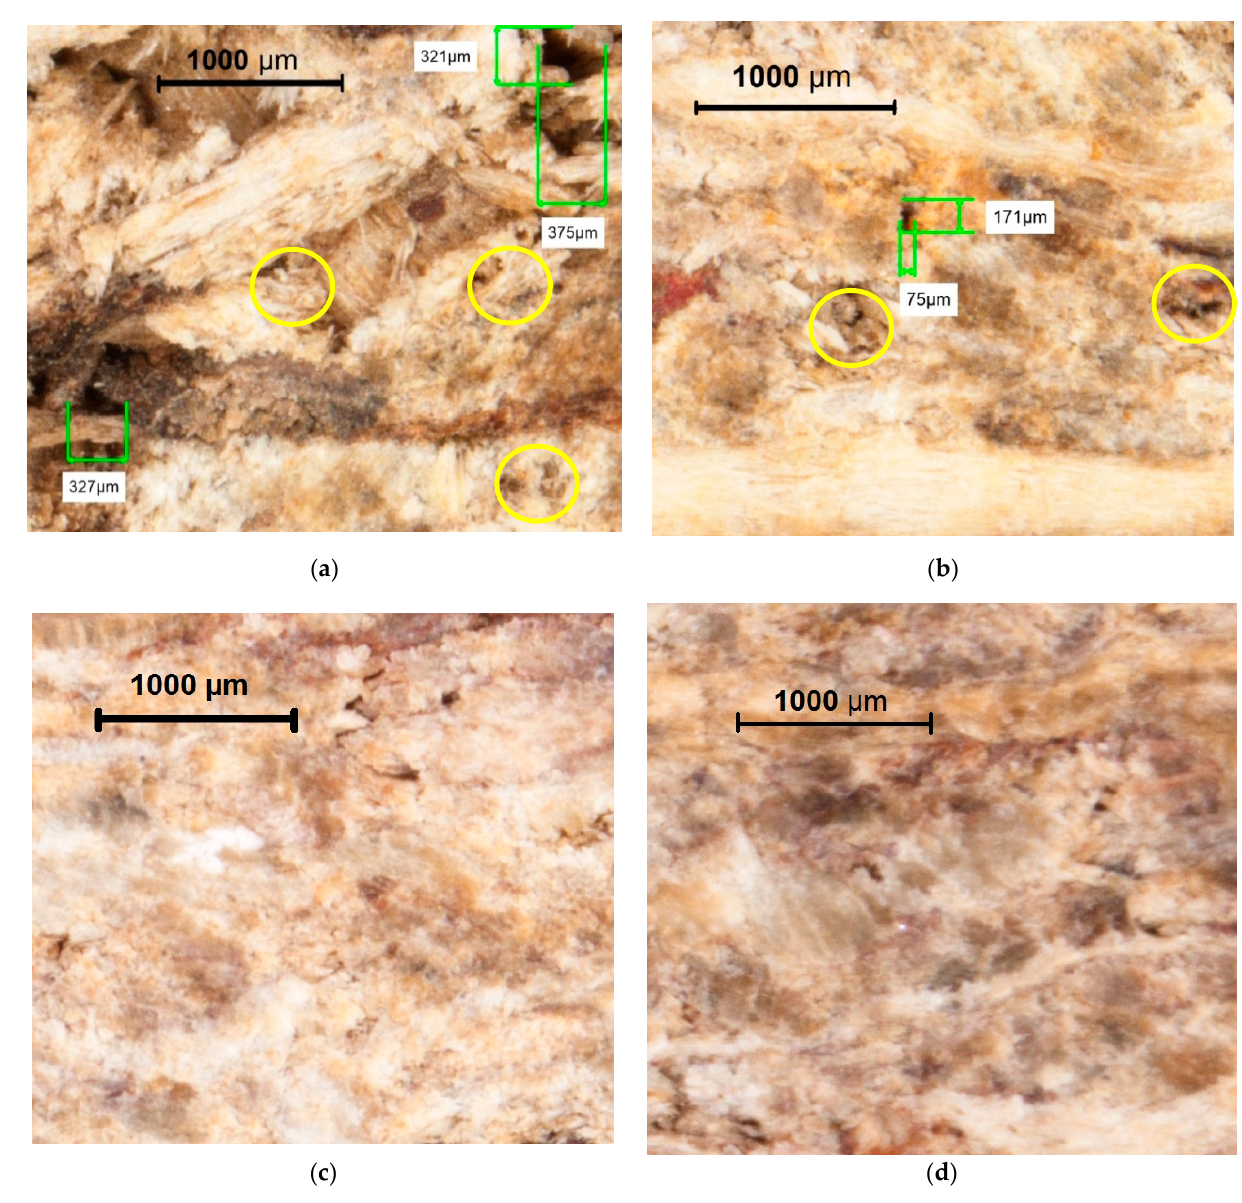
Figure 4. Microscopic investigation of the panels’ structures, 30× magnification: ( a ) LO20; ( b ) LO 20 P2; ( c ) LO 20 P3; ( d ) LO 20 P2G. The circled areas represent the gaps between the wood particles in the structure.